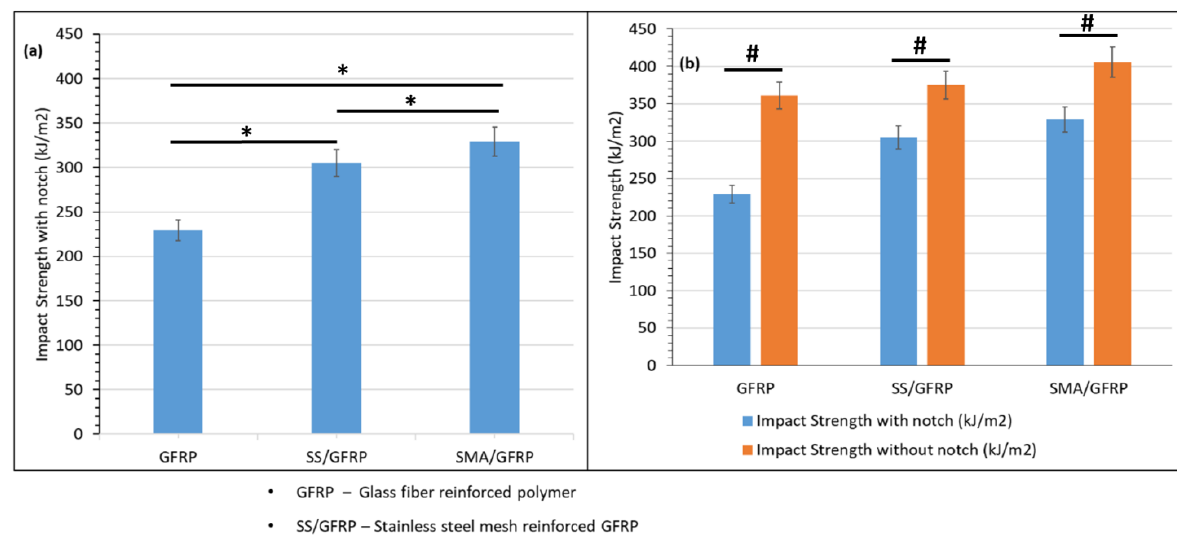
( b ) set B, with dimensions of 6 mm × 6 mm × 57 mm. At a p value of 0.05, the energy consumed in breaking is significantly different for all samples. The difference in the consumed energy with and without the notch is also significant. * symbolizes the significant difference.